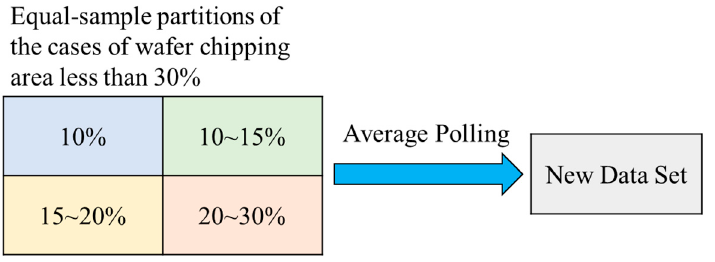
Figure 6. New information from the average pooling of equal-sample partitions.